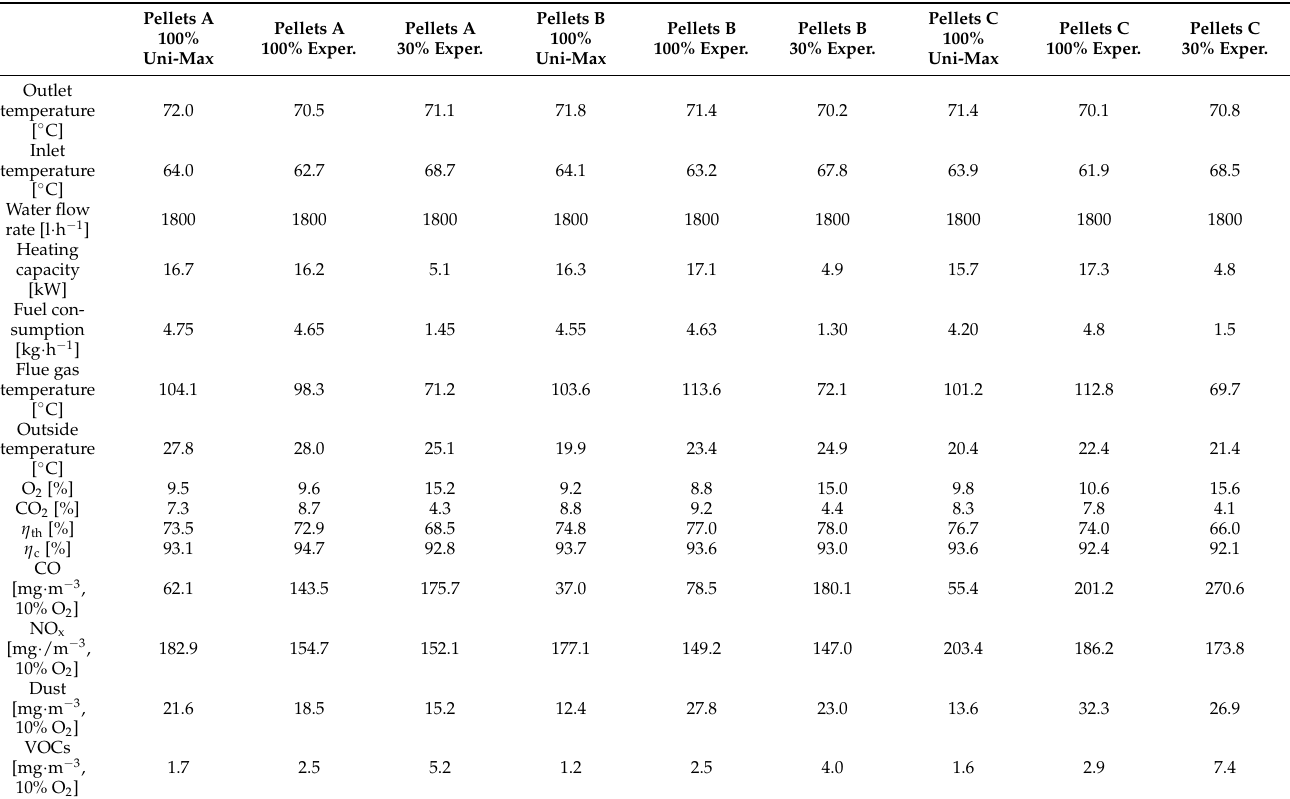
Figure 13. Combustion efficiency for two burners when burning three types of commercial wood pellets at full load. Table 4. Average working parameters of the boiler for two burners and emissions from the combustion of three types of pellets.